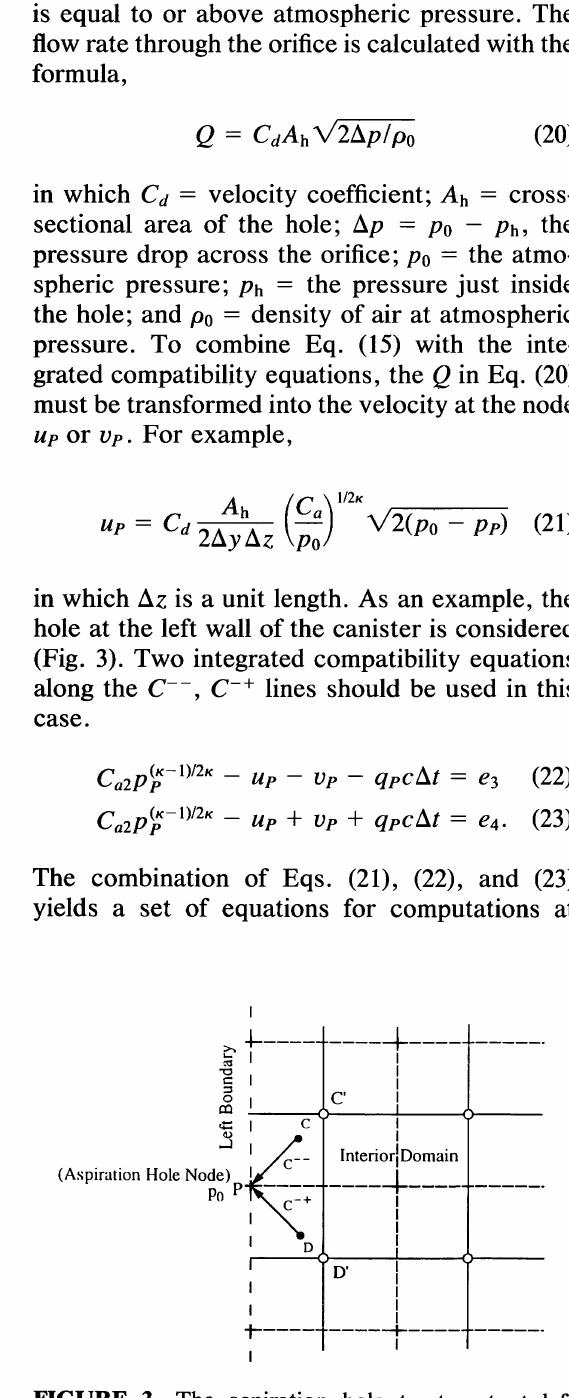
FIGURE 3 The aspiration hole treatment at left